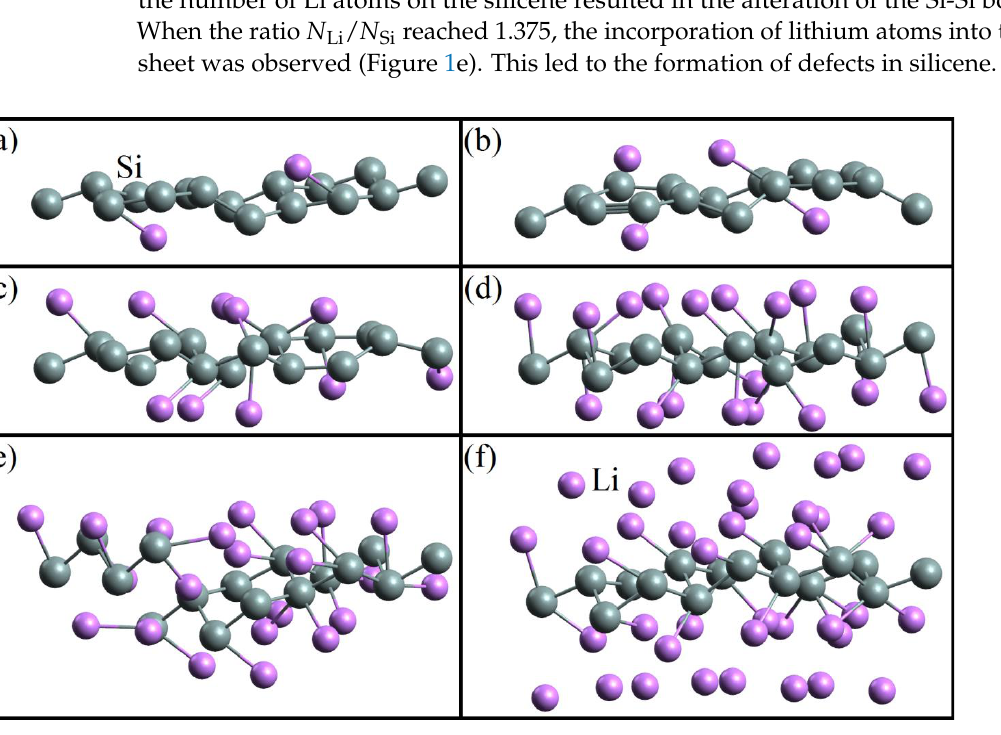
Figure 1. Geometric structure of the silicene/lithium system corresponding to the adsorption ratios: ( a ) 0.125, ( b ) 0.25, ( c ) 0.625, ( d ) 1, ( e ) 1.375, and ( f ) 2.375 [50].